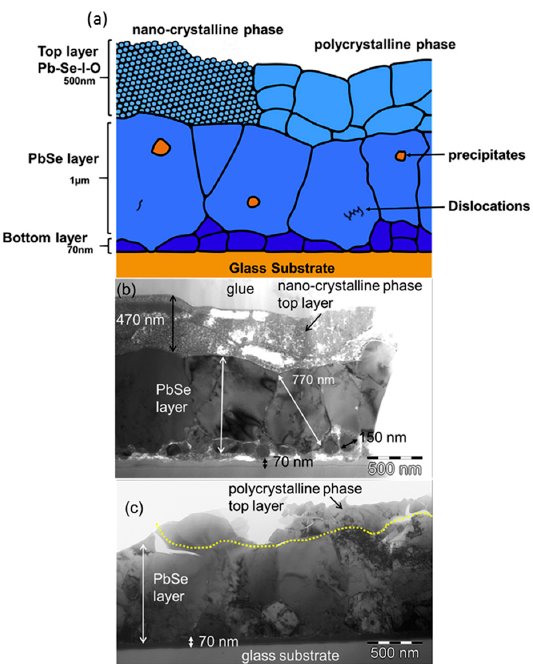
Figure 8. The cross-section structure of PbSe polycrystalline coating sensitized in an oxygen/iodine hybrid atmosphere, ( a ) a schematic, ( b ) nanocrystalline phase, and ( c ) polycrystalline phase. Reprinted with permission from [78]. Copyright Elsevier 2017.